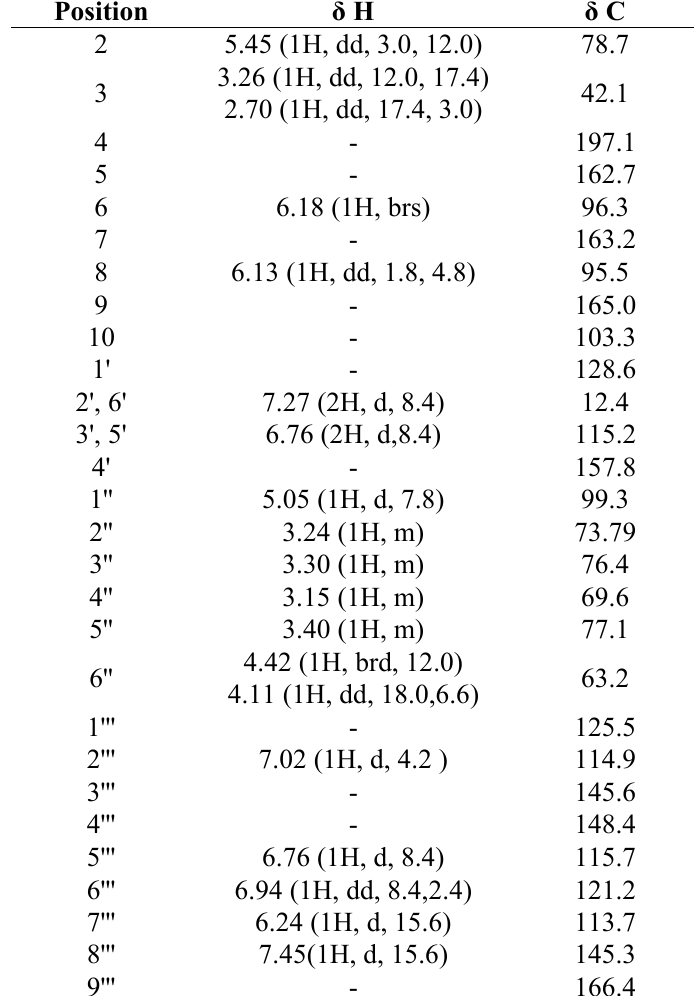
Table 2. 1 H-NMR (600 MHz) and 13 C-NMR (150 MHz) data for compound 2 (DMSO- d δ in ppm, J in H